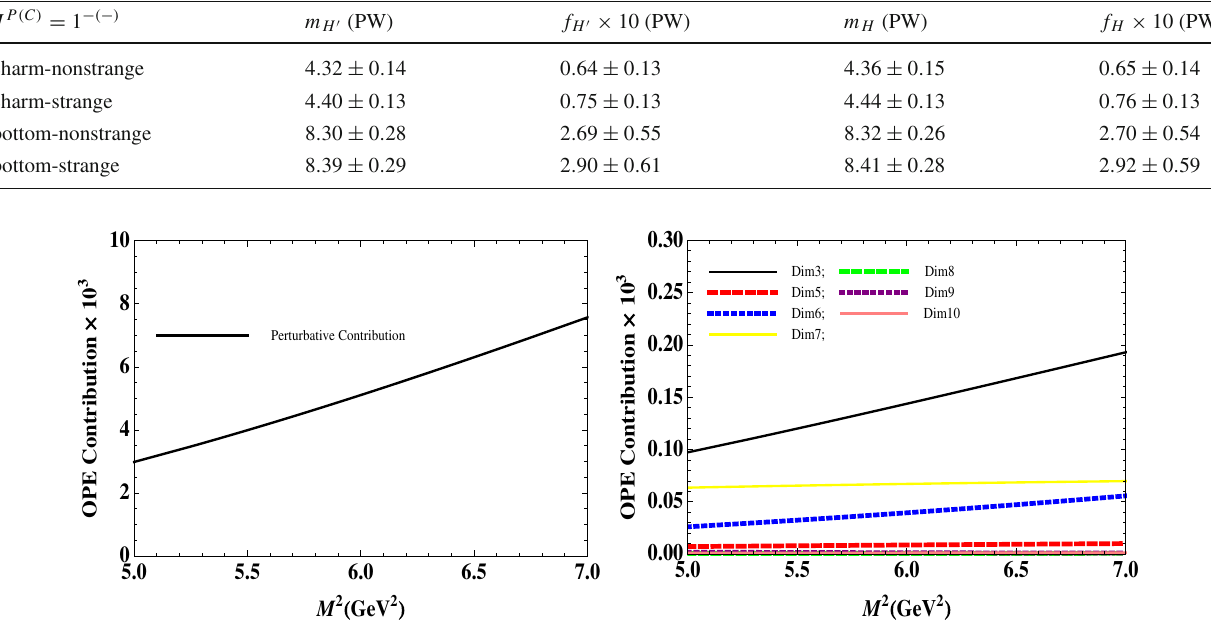
Table 10 Comparison of the values for the mass and current coupling for states with quantum numbers J P ( C ) = 1 − ( − ) of the different heavy- light hybrid mesons obtained by including non-perturbative effects up to six and ten dimensions. The primed masses and decay constants